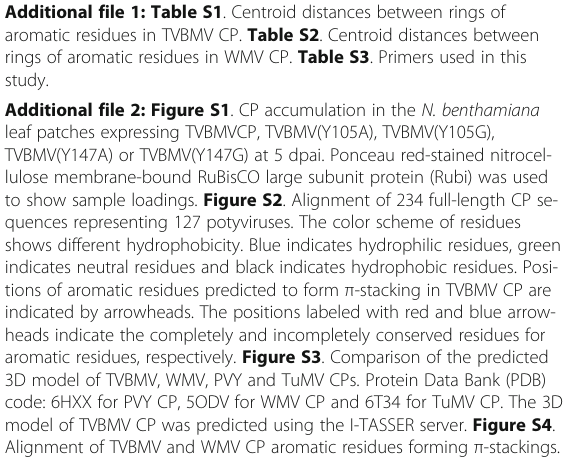
to show sample loadings. Figure S2 . Alignment of 234 full-length CP se- quences representing 127 potyviruses. The color scheme of residues shows different hydrophobicity. Blue indicates hydrophilic residues, green indicates neutral residues and black indicates hydrophobic residues. Posi- tions of aromatic residues predicted to form π -stacking in TVBMV CP are indicated by arrowheads. The positions labeled with red and blue arrow- heads indicate the completely and incompletely conserved residues for aromatic residues, respectively. Figure S3 . Comparison of the